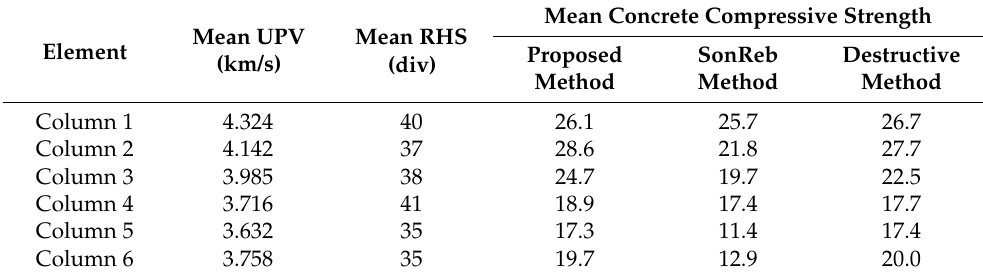
Table 3. The results obtained from each presented method.